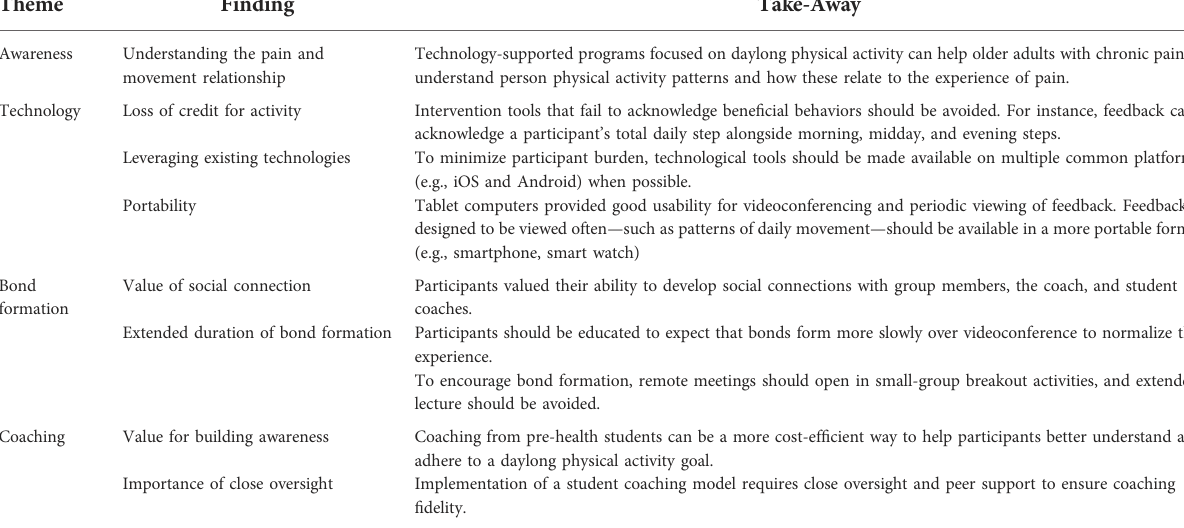
TABLE 3 Key themes, fi ndings, and takeaways based on participant interviews. Theme Finding Take-Away Awareness Understanding the pain and movement